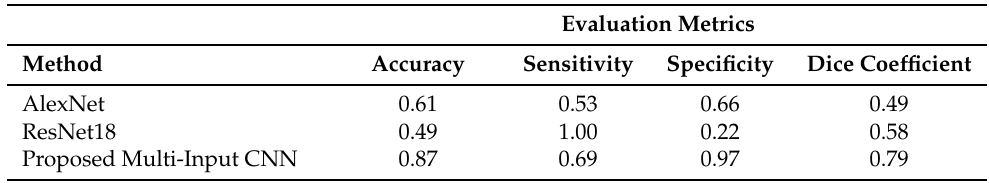
Table 4. Comparative performance of the proposed multi-input CNN system with state-of-the-art CNN-based